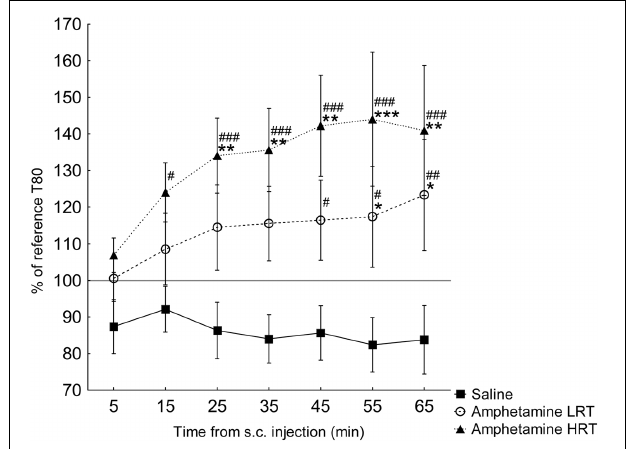
FIGURE 3 | The response in T80 (mean ± s.e.m.) to a subcutaneous (s.c.) injection of amphetamine or saline ( N = 7) shown as the percent of the reference T80. The amphetamine animals were further divided into low (LRT, N = 6) and high risk taking (HRT, N = 7) groups. ∗ p < 0 . 05, ∗∗ p < 0 . 01, ∗∗∗ p < 0 . 001 compared to the saline controls; # p < 0 . 05, ## p < 0 . 01, ### p < 0 . 001 compared to the 5-min time point.